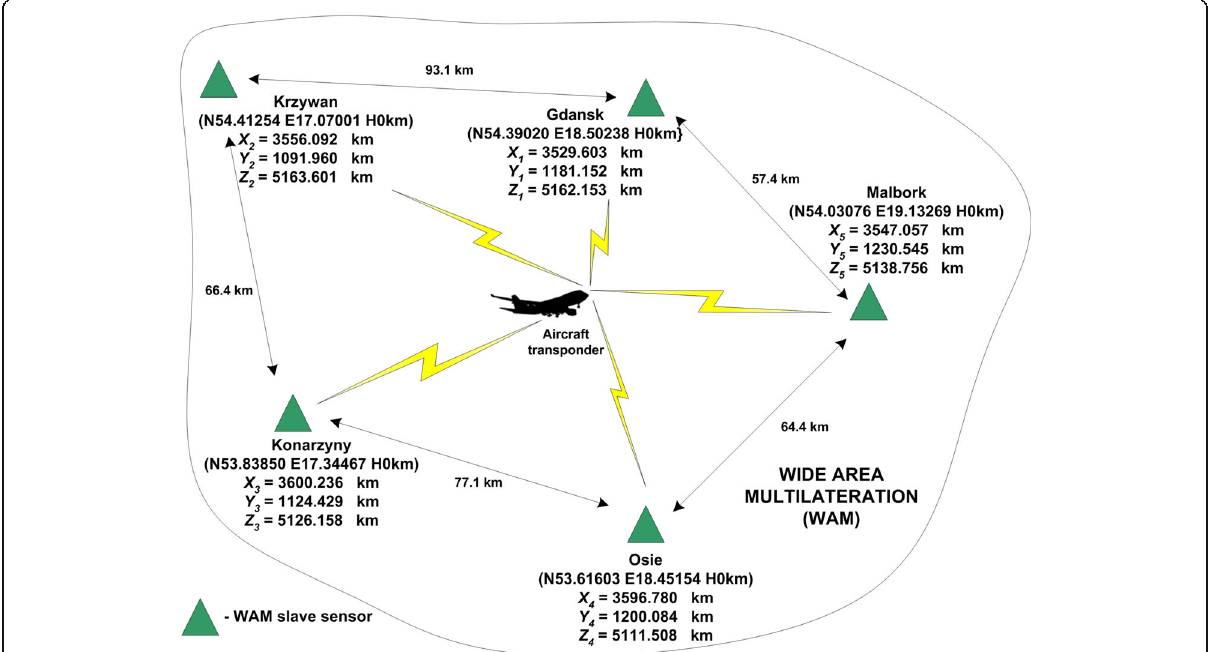
Fig. 3 Simulation model for testing the asynchronous WAM